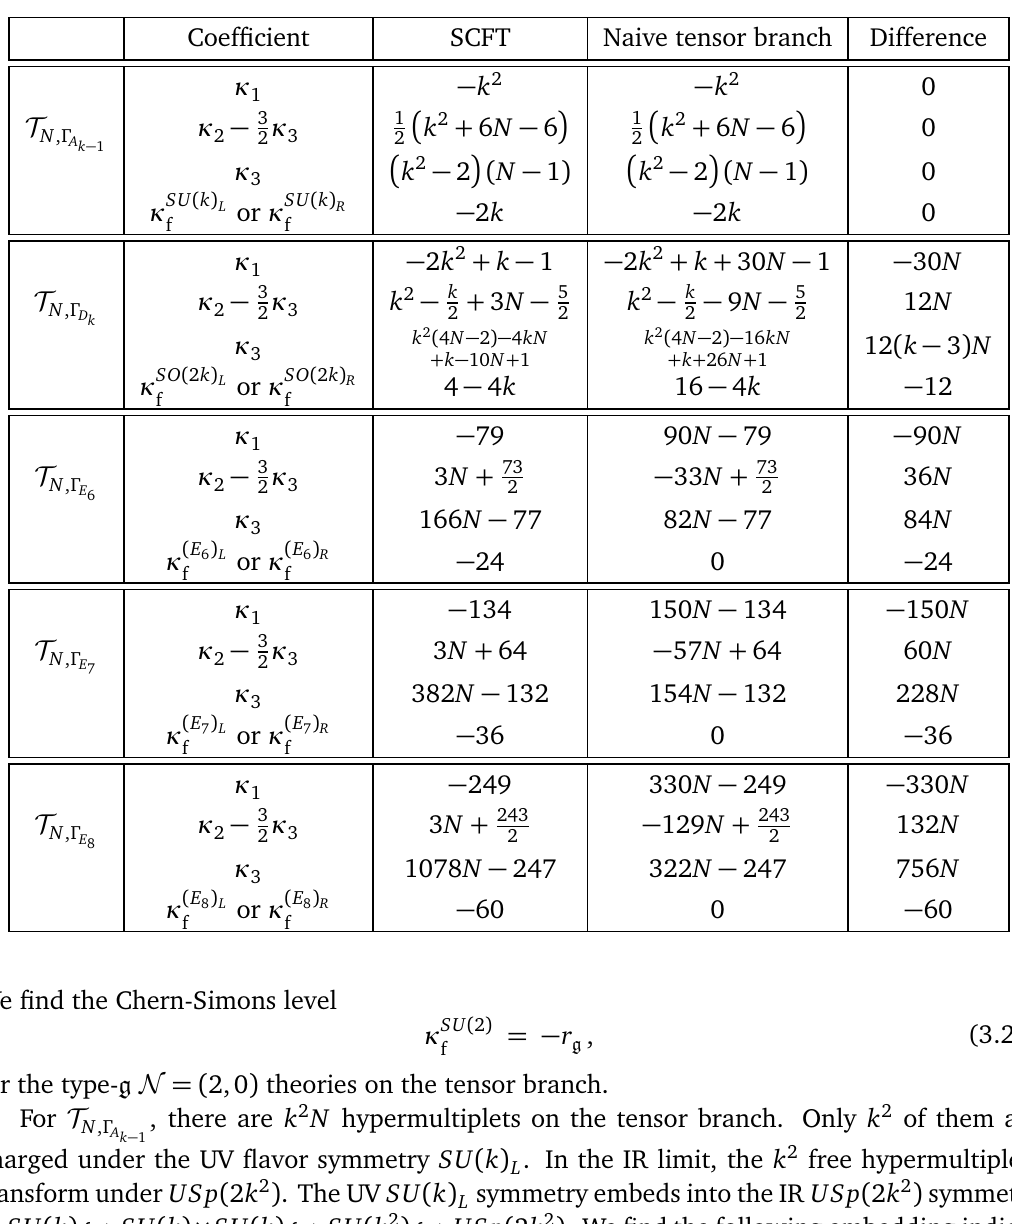
Table 3: Anomaly coefficients κ for an assortment of 6d SCFTs II. We exhibit 1,2,3 both the values computed at the SCFT point using the formula (1.16), and the naive values by simply adding free fields on the tensor